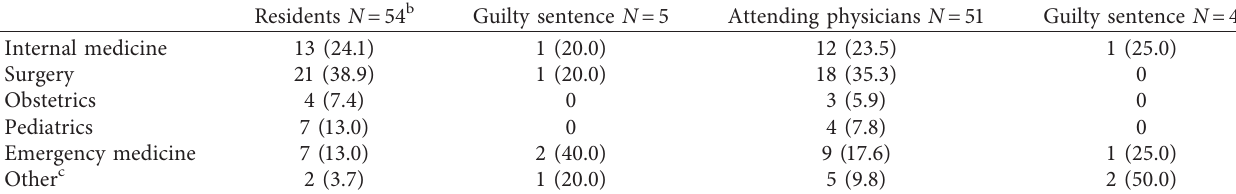
Table 1: Number and percentage of physicians involved in 40 malpractice claims in each specialty group a